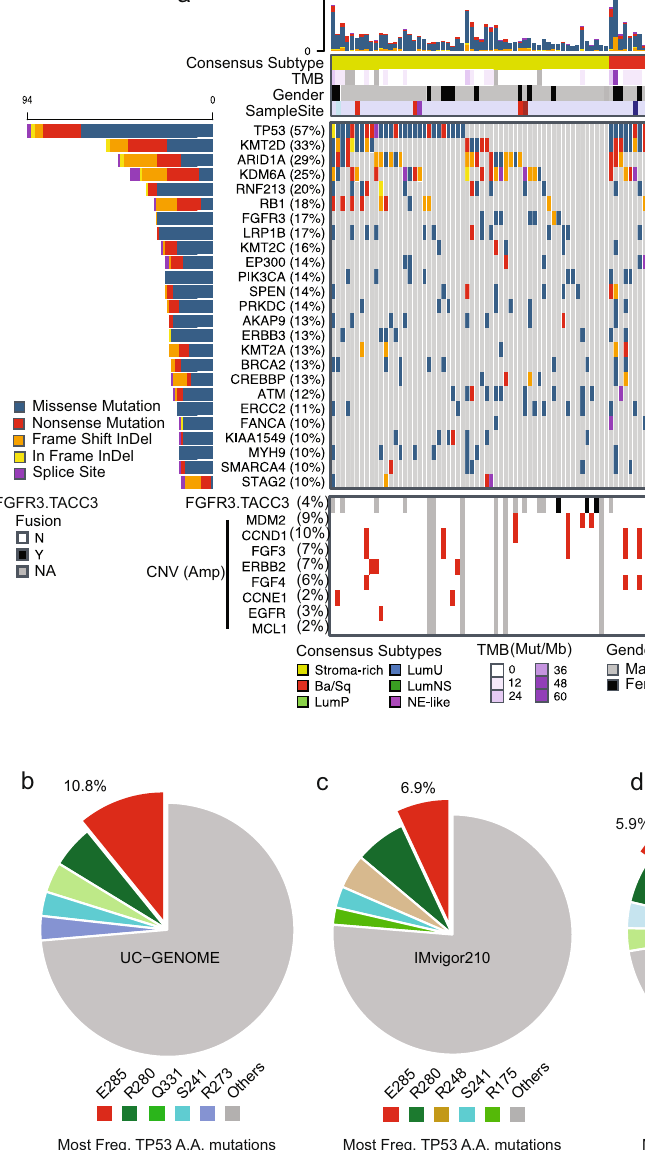
section) are shown in lower panel. VAF=average variant allele frequency, InDel =Insertion or deletion, Mb=Megabase. b Number of TP53 E285 mutations